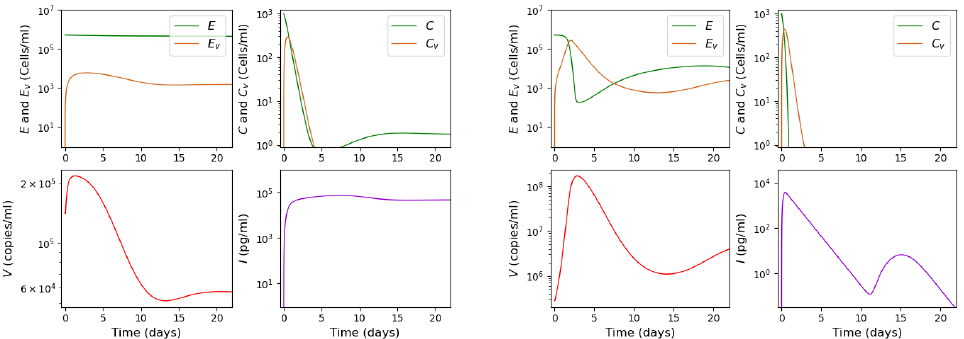
Figure 4. Numerical simulations of system (1)–(6). Behavior of solution for different initial viral loads in the bistable case. Left two columns: initial viral load V ( 0 ) = 141 · 10 3 leads to the convergence to the first stable stationary solution. Right two columns: initial viral load V ( 0 ) = 28 · 10 4 leads to convergence to the second stable stationary solution. The colors of the curves correspond to the colors of rectangles in Figure